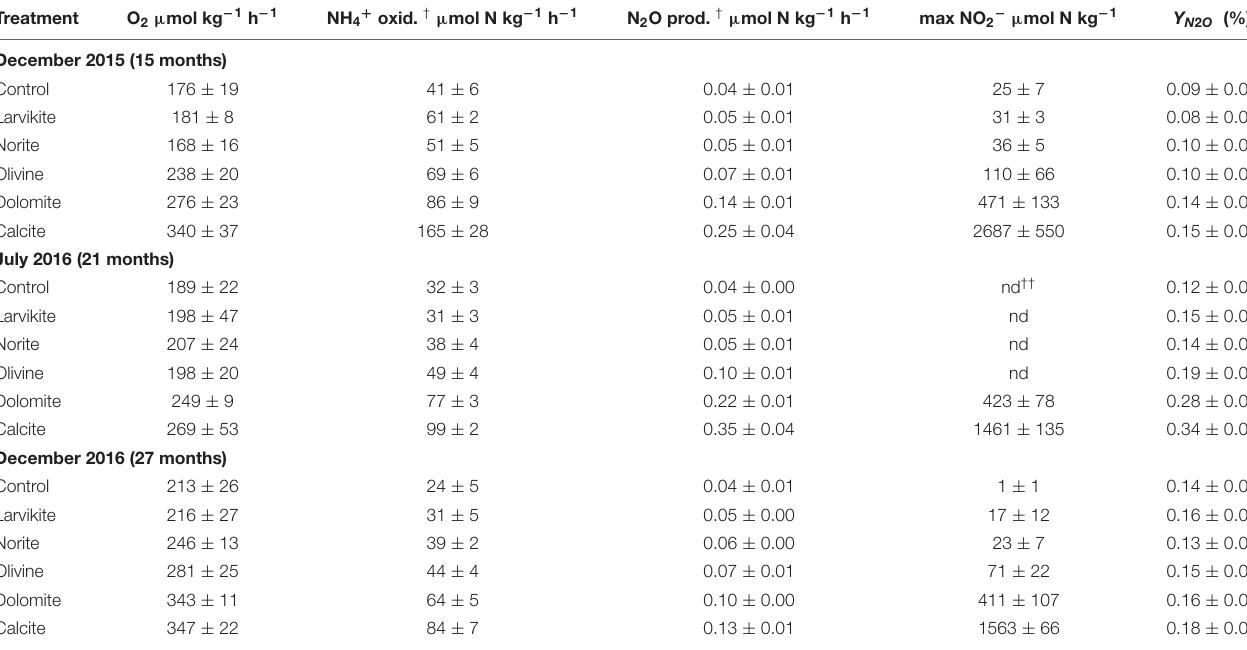
TABLE 3 | Rates of O 2 consumption, ammonium oxidation, N 2 O production, NO 2 − accumulation and N 2 O yield ( Y N 2 O ) in oxic slurry incubations.